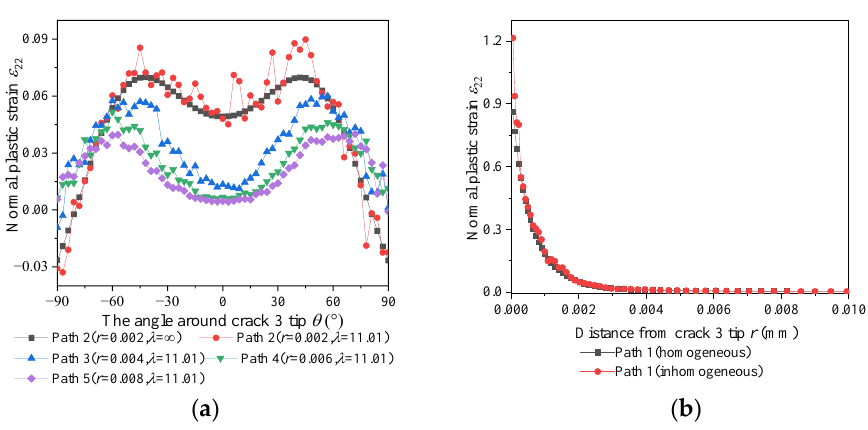
Figure 12. Normal plastic strain at the tip of crack 3 ( a ) homogeneous ( b ) inhomogeneous.